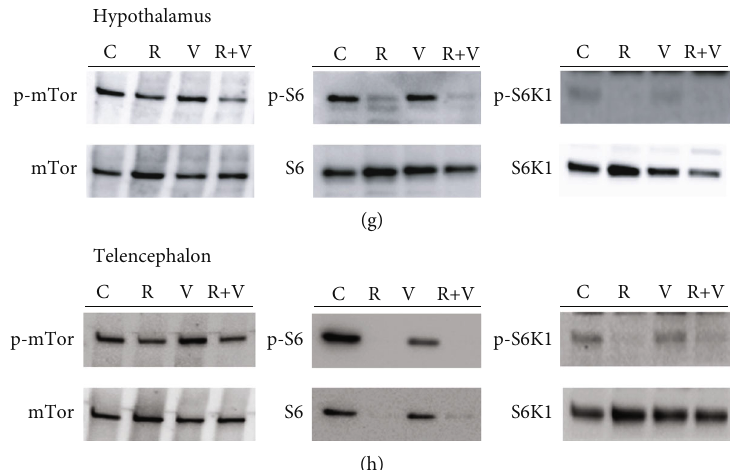
Figure 2: Phosphorylation status of mTOR (a, b), S6 (c, d), and S6K1 (e, f) in the hypothalamus (a, c, e) and telencephalon (b, d, f) of rainbow trout 6 h after intracerebroventricular injection of 1 μ L · 100g -1 body mass of a solution containing saline and dimethyl sulfoxide (DMSO) alone (control) or containing 20 mM rapamycin (R), 80 mM of L-valine (V), or rapamycin with valine (R+V). Values are mean + SEM of N = 6 fi sh per treatment. One representative blot per treatment is shown for the hypothalamus (g) and telencephalon (h). Signi fi cant di ff erences ( P < 0 : 05 ) among groups are denoted with di ff erent